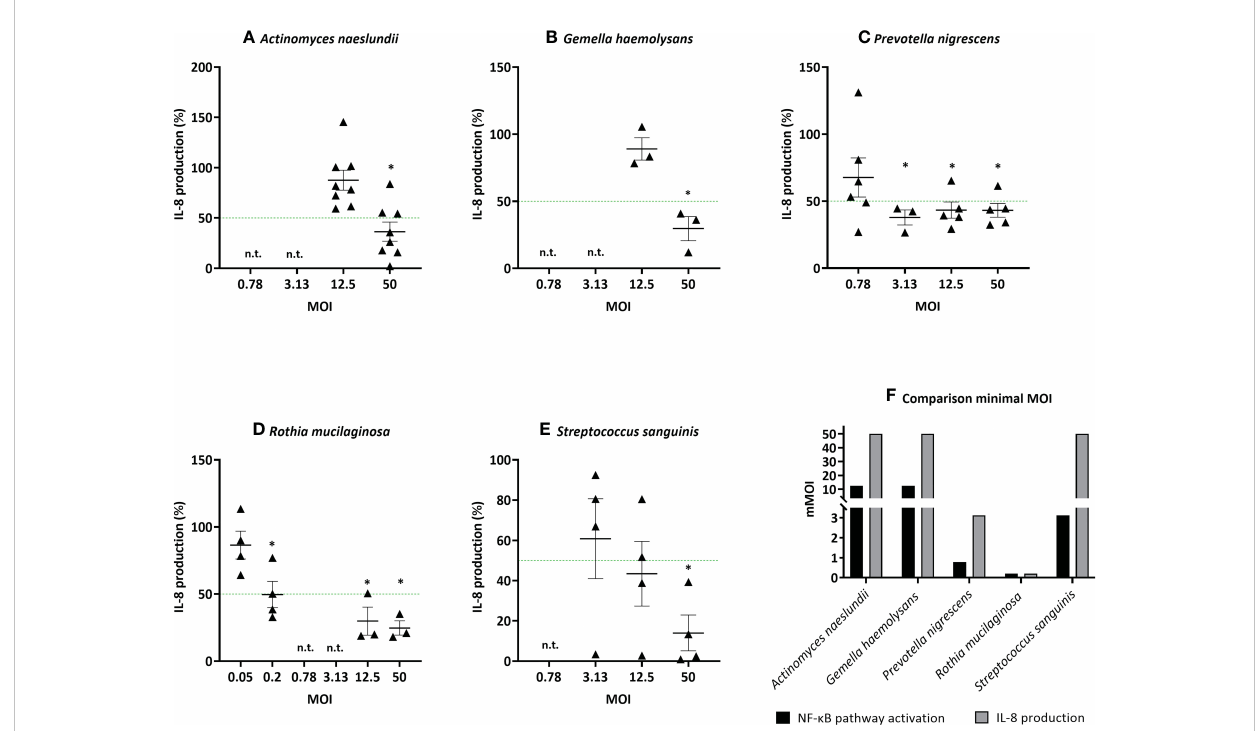
FIGURE 5 Determination of the minimal effective MOI (mMOI IL-8 ) of commensal bacteria in (3D) A549 cells based on IL-8 secretion. Selected lung commensals at different MOI were cultured with LPS and the mMOI IL-8 was determined using an ELISA for IL-8 quanti fi cation, with (A) A. naeslundii , (B) G. haemolysans , (C) P. nigrescens , (D) R. mucilaginosa , (E) S. sanguinis . On the vertical axis % IL-8 production compared to LPS-stimulated cells is shown, on the horizontal axis the tested MOI is depicted. The mMOI IL-8 was de fi ned as the lowest MOI with anti-in fl ammatory activity (i.e.< 50% IL-8 production compared to LPS- stimulated cells as visualized by a green line, p< 0.05). *: p< 0.05, n ≥ 3, n.t.: not tested. (F) Comparison of the minimal MOI for inhibition of NF- k B pathway activation and IL-8 production. On the vertical axis the minimal MOI is shown, on the horizontal axis the selected microbiota members are depicted.